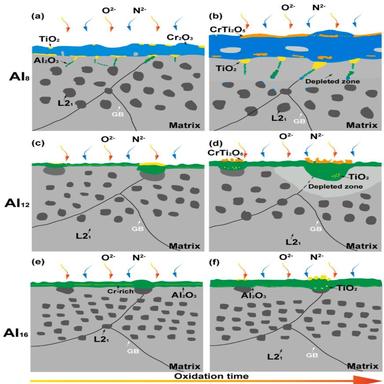
The schematic diagram of the oxidation mechanism of Fe71.5-x(Ni, Cr, Ti)28.5Alx CCAs at 800 ◦C in air.